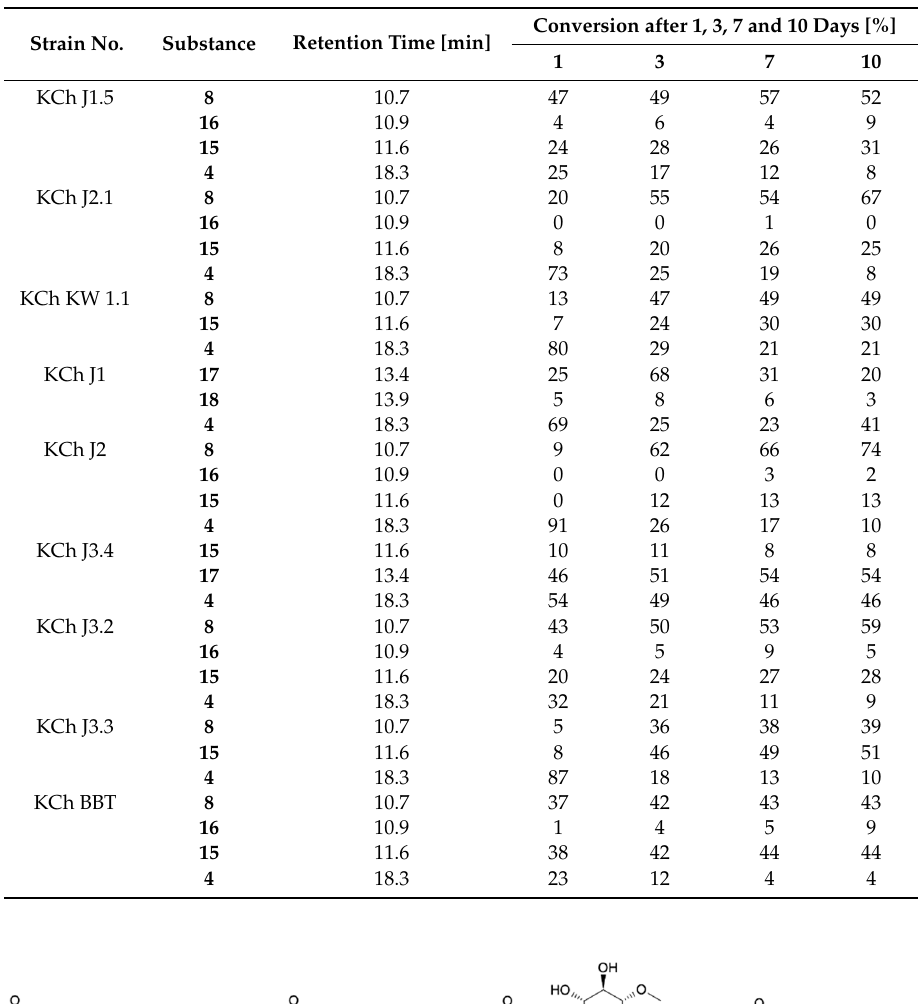
Table 5. Microbial transformation of 2 (cid:48) 5 (cid:48) -dimethoxyflavone ( 4 ), HPLC conversion. Strain No.